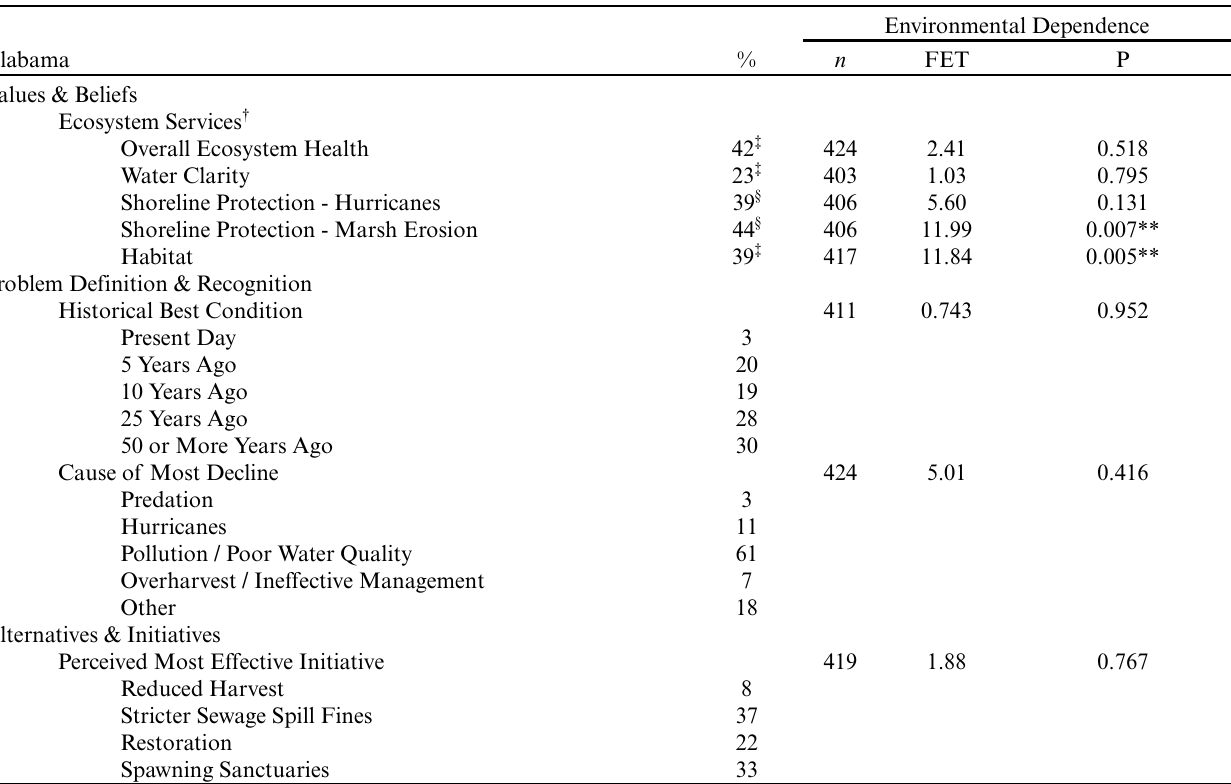
Table 2 . Survey response descriptives and results of Fisher’s Exact Tests (FET) on environmental dependence for Alabama.